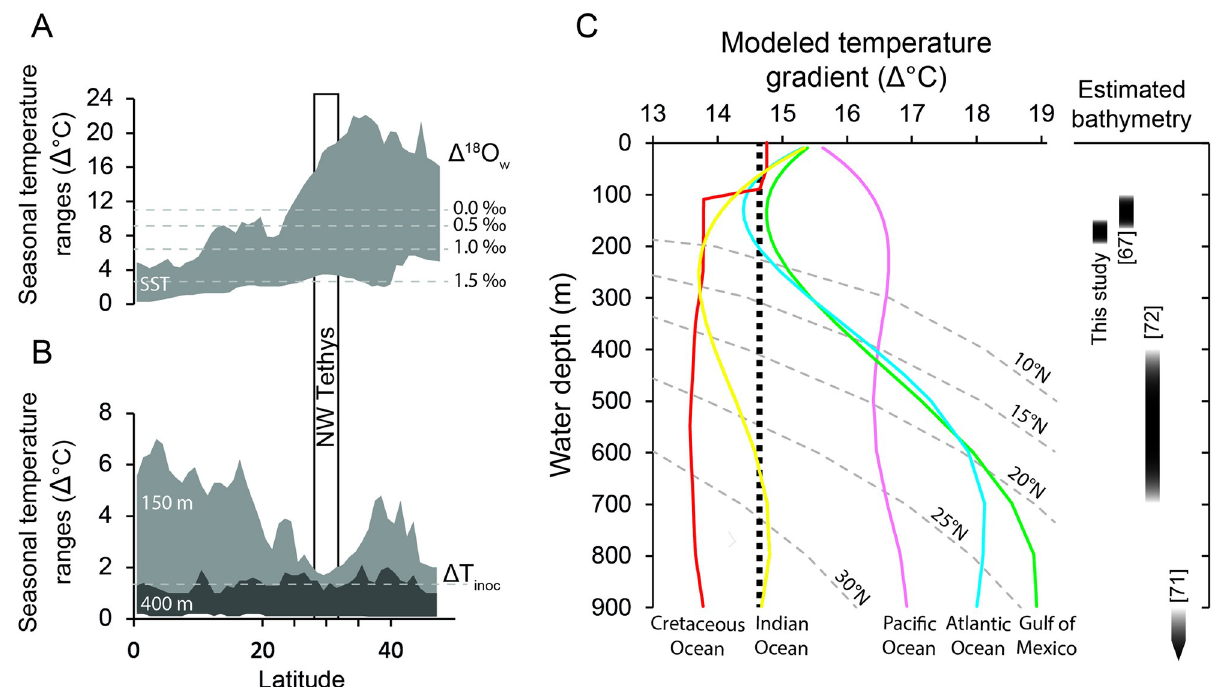
Fig 6. Comparison between inferred late Turonian/Early Coniacian water temperatures and observational data from modern tropical oceans. (A) Annual water temperature amplitudes ( Δ T) of the studied shallow water environment of the Tethys (dashed lines) reconstructed from the sclerochronologically sampled δ 18 O values of the rudist shells (Fig 4A) are compared to the latitudinal changes of the seasonal near-surface (2.5–7.0 m) temperatures observed in modern oceans (gray shadow) [112]. When seasonal changes in δ 18 O w ( Δ 18 O w ) are taken into account, the reconstructed Δ T ranges become narrower (see text for detailed explanation). (B) Similar to (A), the estimated seasonal Δ T amplitude for the hemipelagic environment was compared to observed Δ T ranges in modern oceans at 150 m (light gray) and 400 m (dark gray) water depth [112]. (C) Results of our model on the effect of bathymetrical δ 18 O w changes on the reconstruction of the vertical temperature gradient (see method for detailed explanation). Vertical Δ T gradients were calculated from the rudist and inoceramid data assuming the vertical δ 18 O w changes modeled for the Late Cretaceous oceans [82] as well as observed in the modern Indian (yellow), Pacific (pink), and Atlantic Oceans (blue) and the Gulf of Mexico (green) [83]. The gray dotted line depicts zonally averaged vertical Δ T gradients. Bathymetries (black bars) of the Trento Plateau inferred in the present and previous studies [67,71,72]are depicted to the